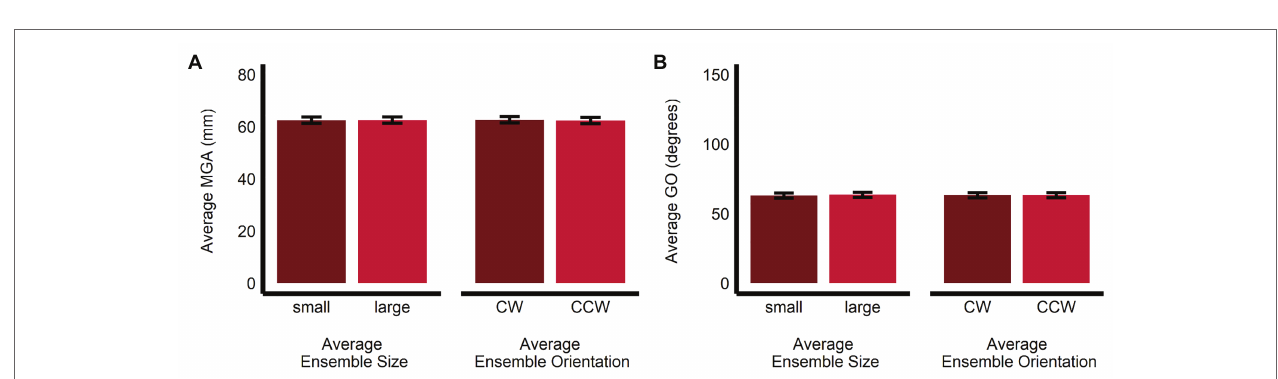
FIGURE 6 | Univariate results of the grasping task. Estimated marginal means of average (A) maximum grip aperture and (B) grip orientation are given for the small and large average size ensemble displays, and for the CW and CCW average orientation ensemble displays. Error bars depict SEM; MGA, maximum grip aperture; GO, grip orientation; CW, clockwise; CCW,